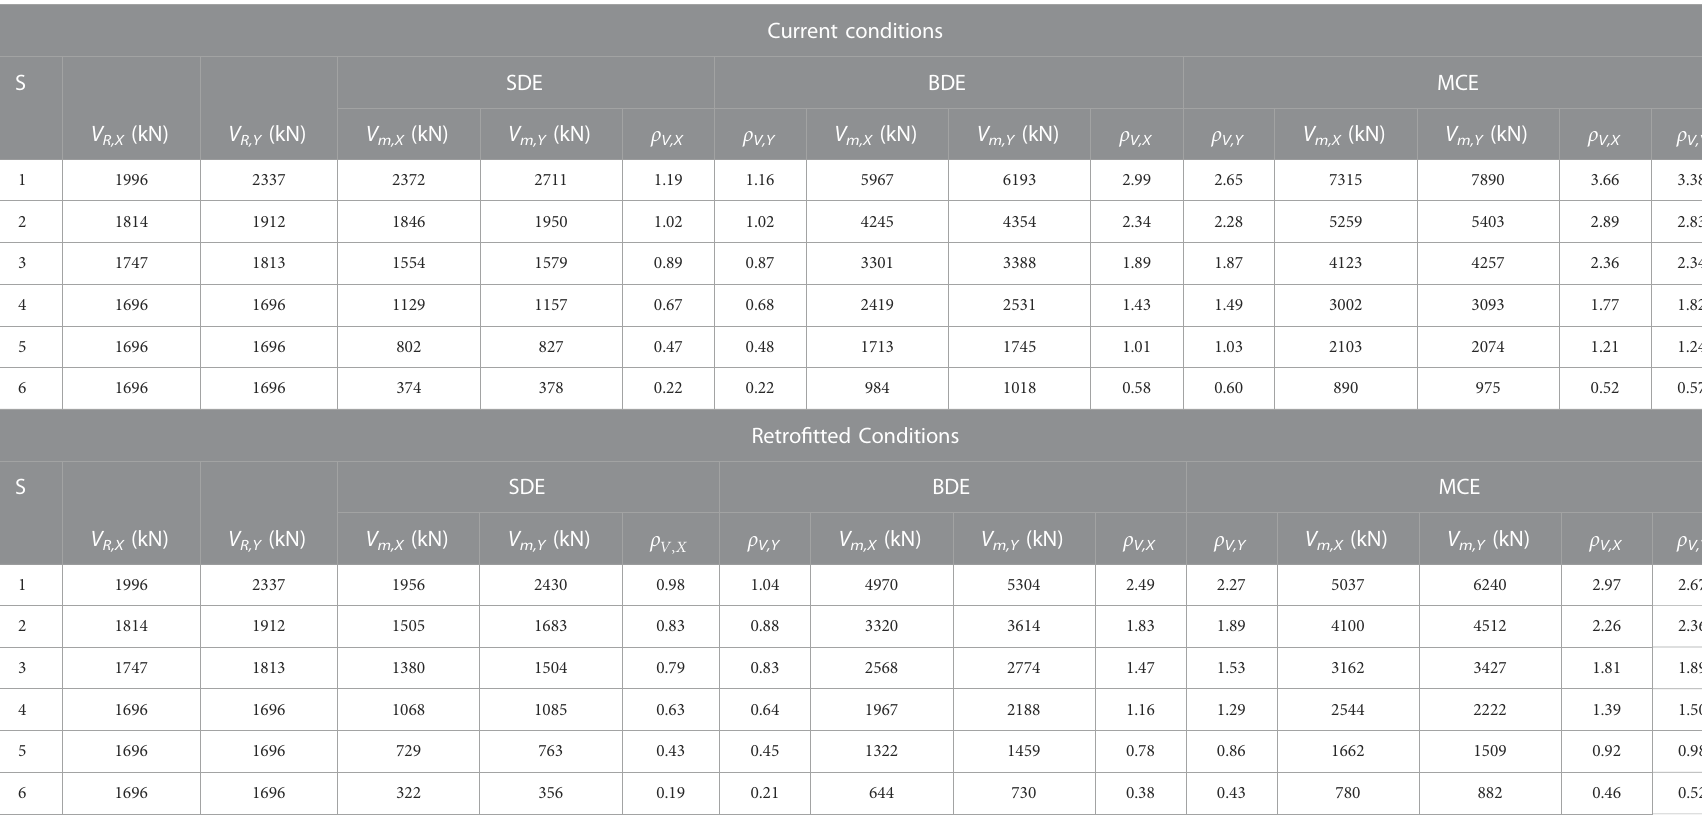
TABLE 2 V m,X , V m,Y maximum storey shears, and corresponding ρ V,X , ρ V,Y ratios to relevant V R,X , V R,Y strength values, in current and retro fi tted conditions.